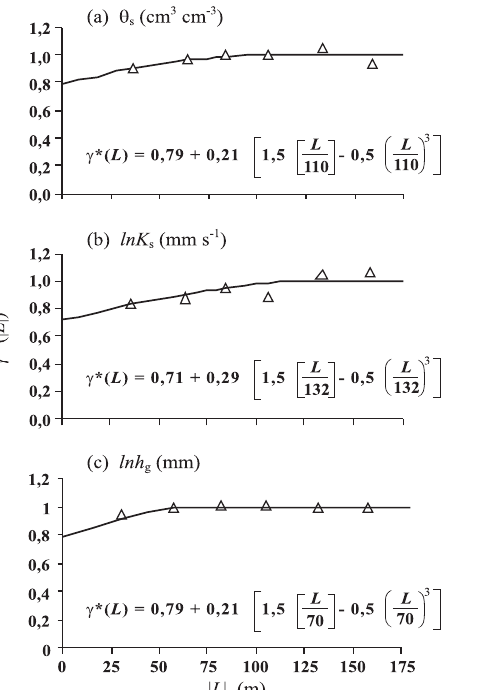
, lnKs e ln | hg |. Neossolo Flúvico s